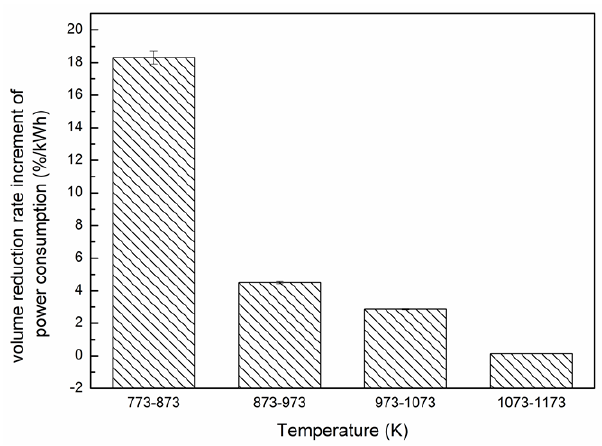
Figure 10. Volume reduction rate increment of unit power consumption in different temperature phases.